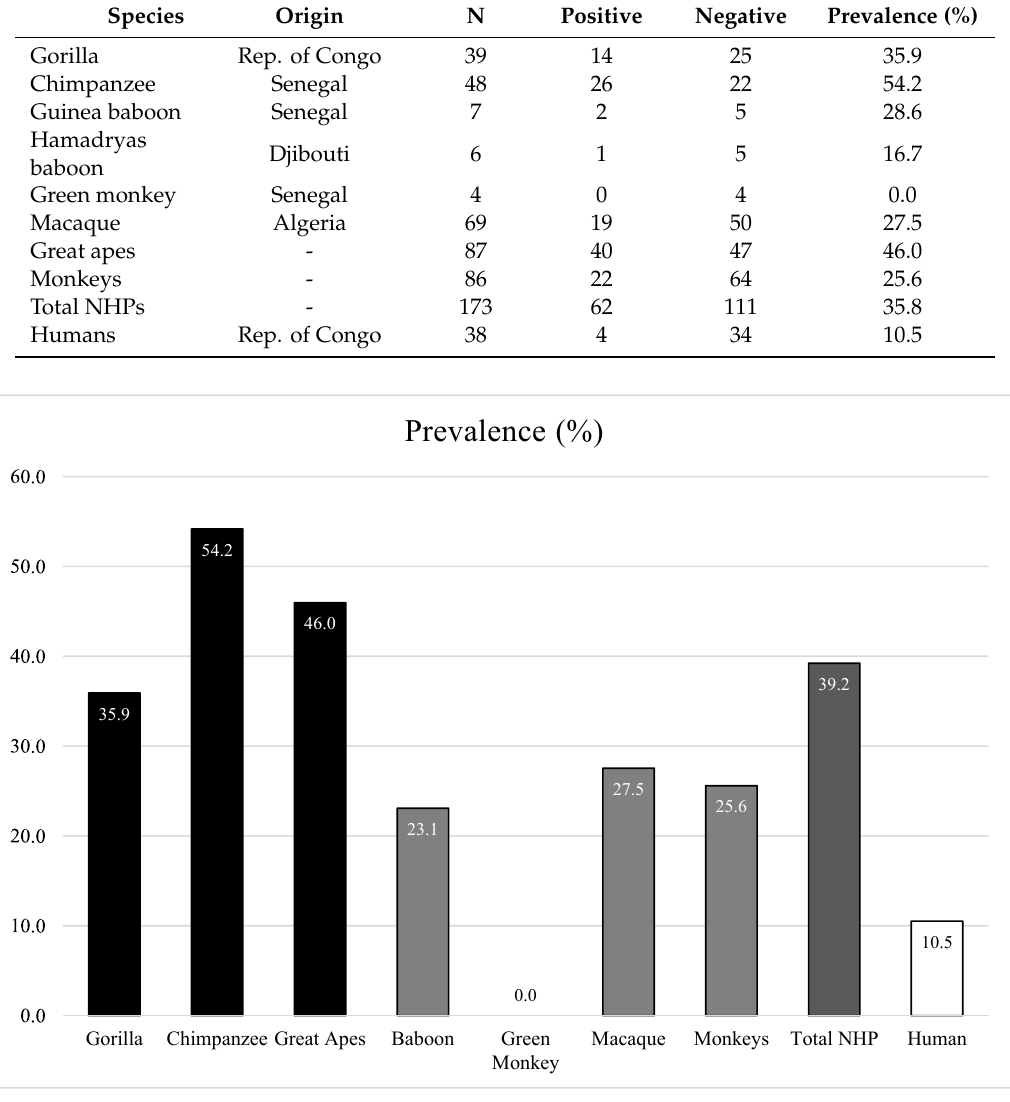
Figure 1. Prevalence of adenoviruses in African humans and NHPs. Deep dark : Great apes, including gorillas from the Republic of Congo and chimpanzees from Senegal. Gray : Monkeys, including Guinea baboons from Senegal, hamadryas from Djibouti and Algerian Barbary macaques from Algeria. White : humans from the Republic of Congo, living in contact with gorillas.